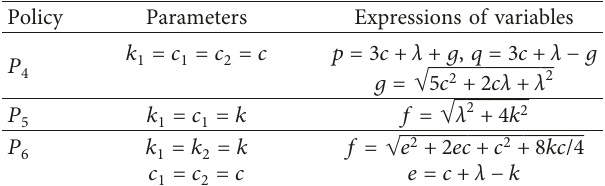
Table 2: Advertising policy parameters and expressions of variables in special cases of affine